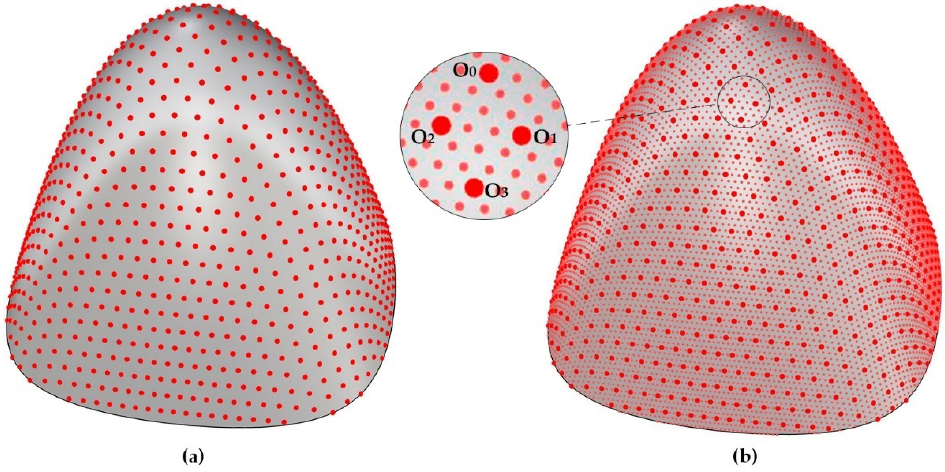
Figure 11. Compass Method ( a ) and Improved Compass Method ( b )